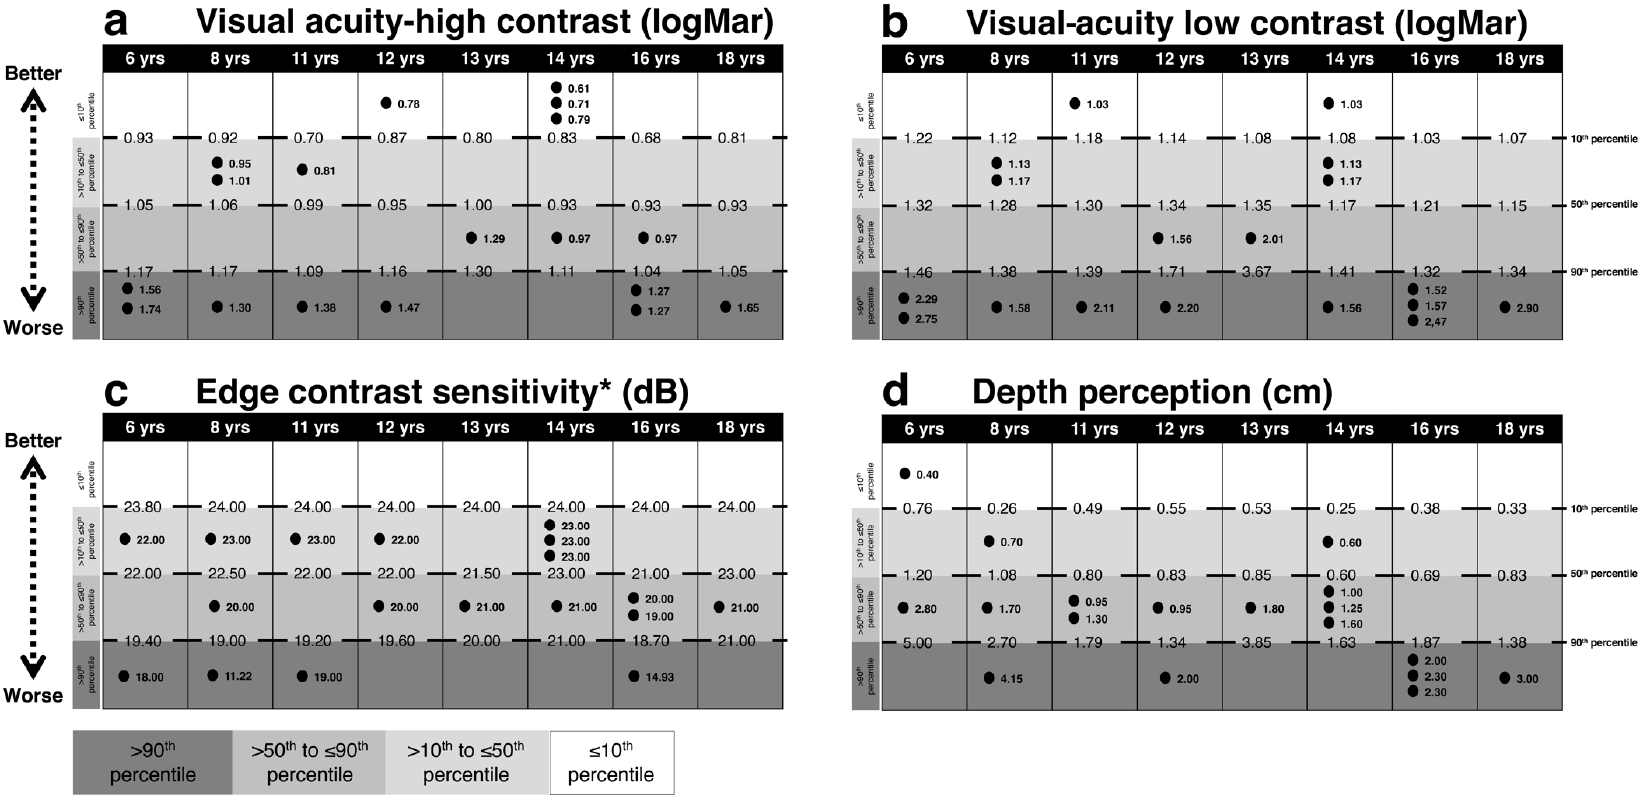
Figure 1. Comparison between each ASD subject’s performance in the Physiological Profile Assessment (PPA) vision tests and age-matched reference values (percentiles) for typically developing (TD) subjects. Light gray to dark gray corresponds with better to worse performance. In ( a ) visual acuity high-contrast, in ( b ) visual acuity low-contrast, in ( c ) edge contrast sensitivity, in ( d ) depth perception. The reference value of the 10th, 50th and 90th percentiles and each ASD subject values are reported. Intervals for each performance represent: ≤ 10th, 10th < x ≤ 50th, 50th < x ≤ 90th, >90th percentile from the top to the bottom, respectively. Abbreviations: yrs, years; LogMar, minutes of arc; dB, decibel units; cm, centimeters. * indicates the percentile scale was inverted, i.e., for all items a score over the 90th percentile is an indicator of a worse performance.